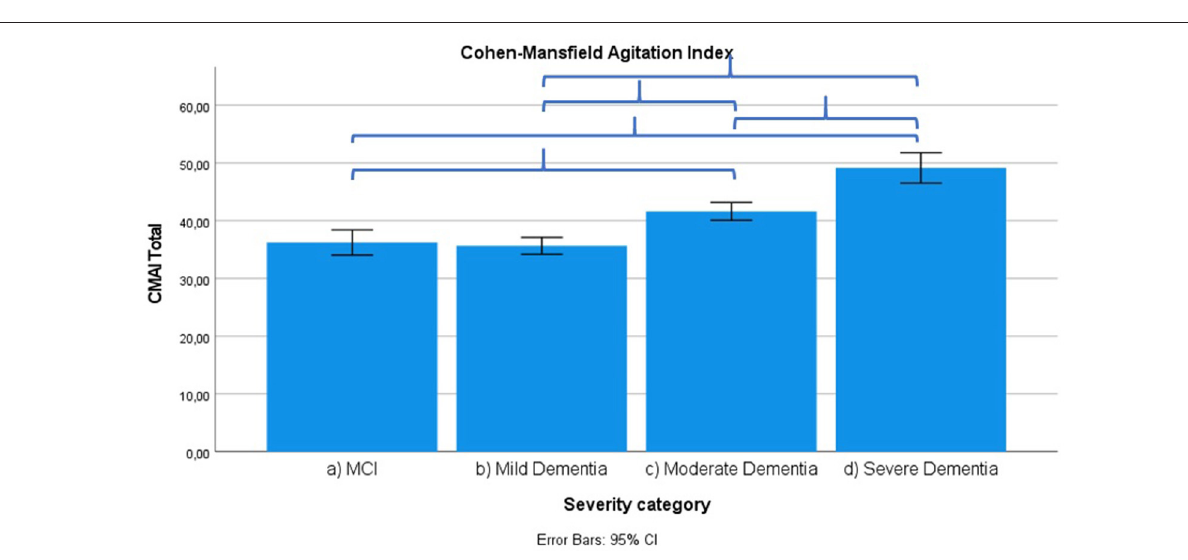
FIGURE 5 | Mean score on Cohen-Mansfield Agitation Index (CMAI) score according to severity of cognitive impairment. Error bars are 95% confidence interval. Curly brackets indicate p <